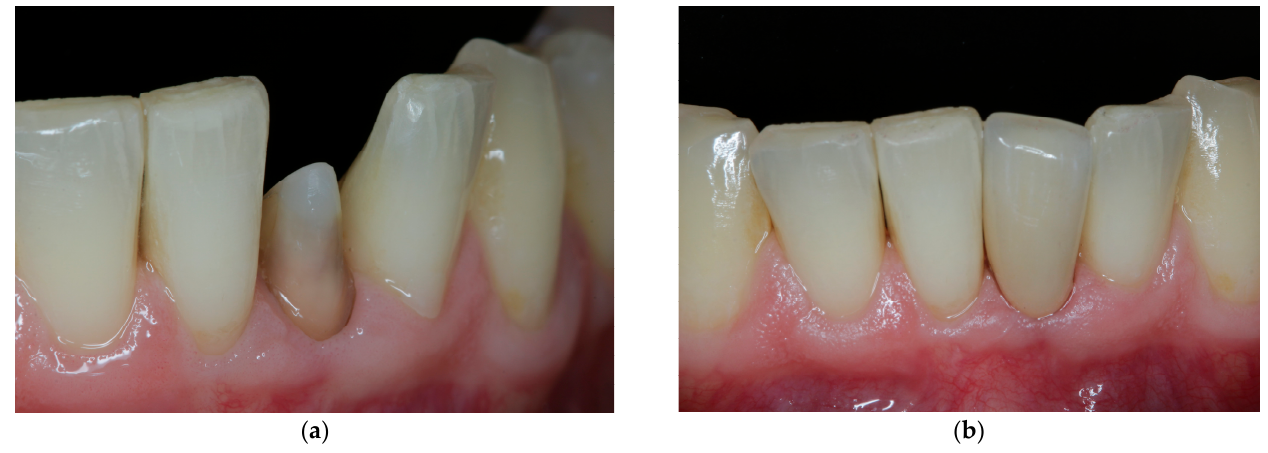
Figure 7. Final restoration. ( a ) Preparation from buccal aspect. ( b ) Final restoration in situ.